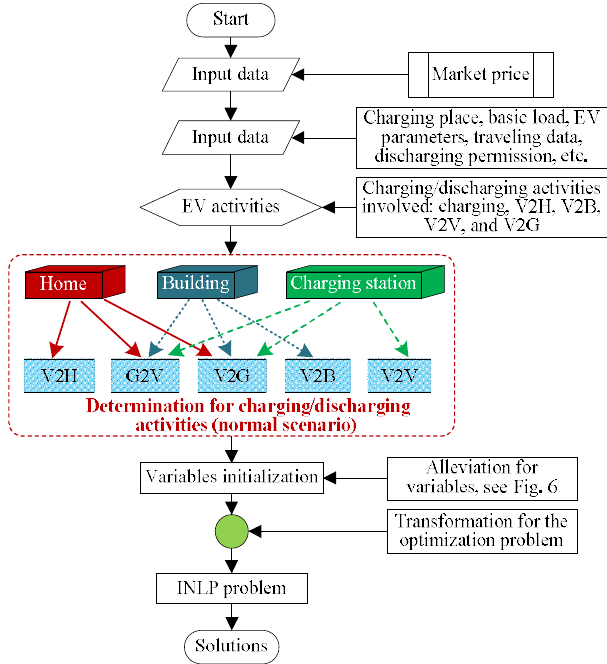
Figure 7. Optimization process for different V2A applications.